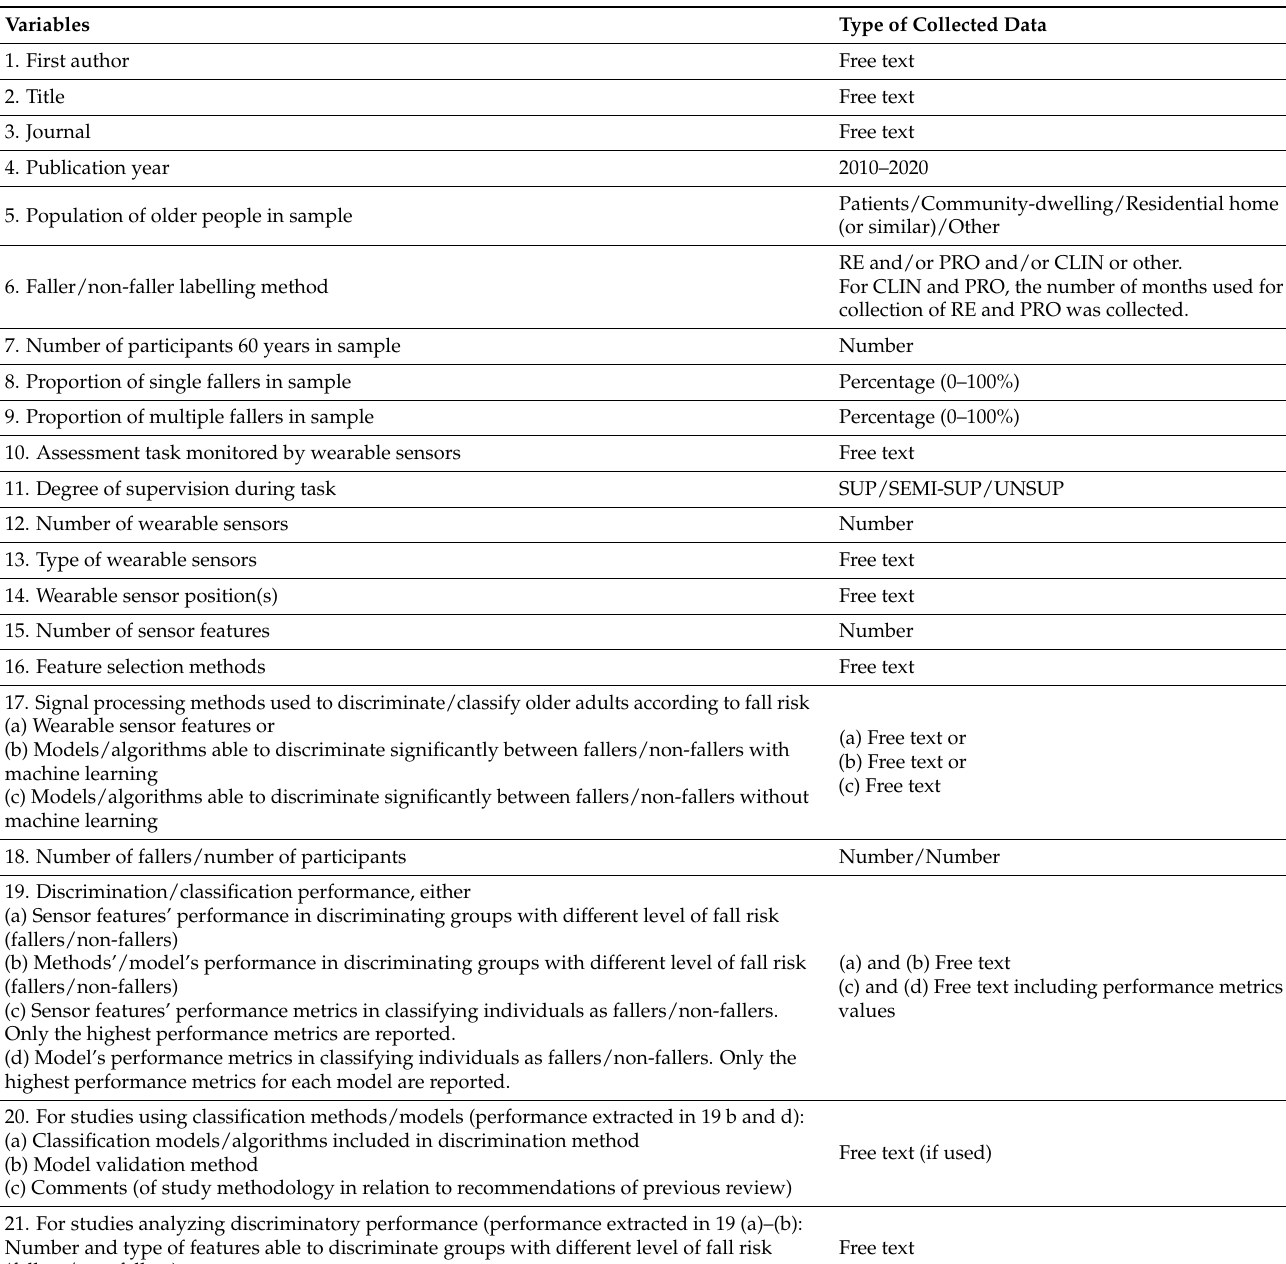
Table A1. Template for data